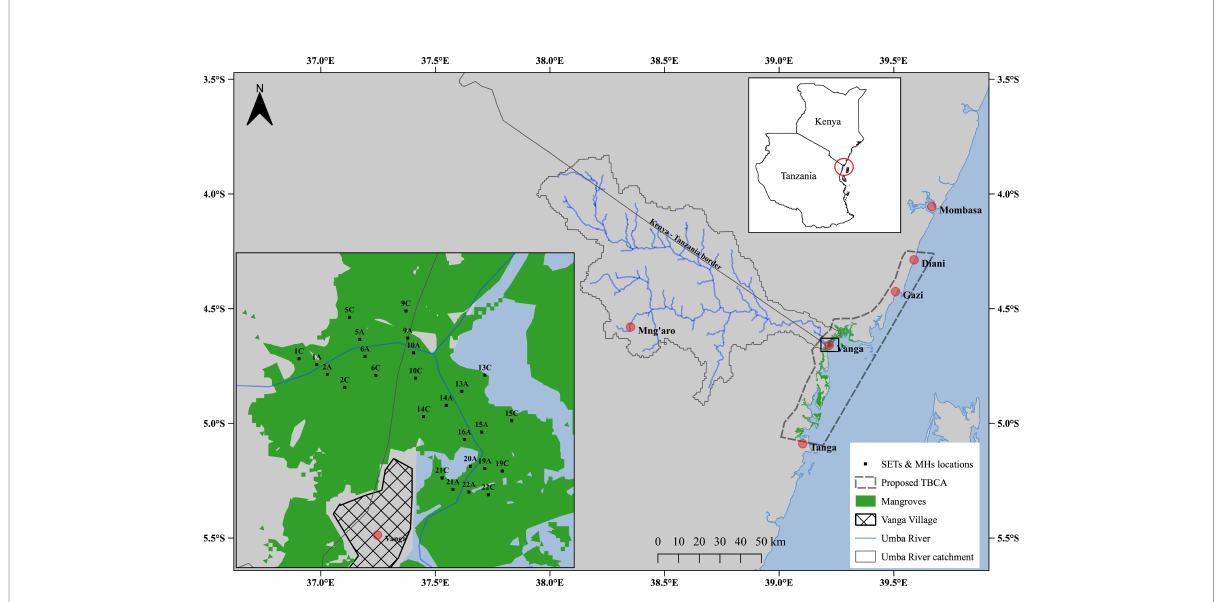
FIGURE 3 Location of the study area in Vanga, Kenya, showing the experimental plots perpendicular to the main creek